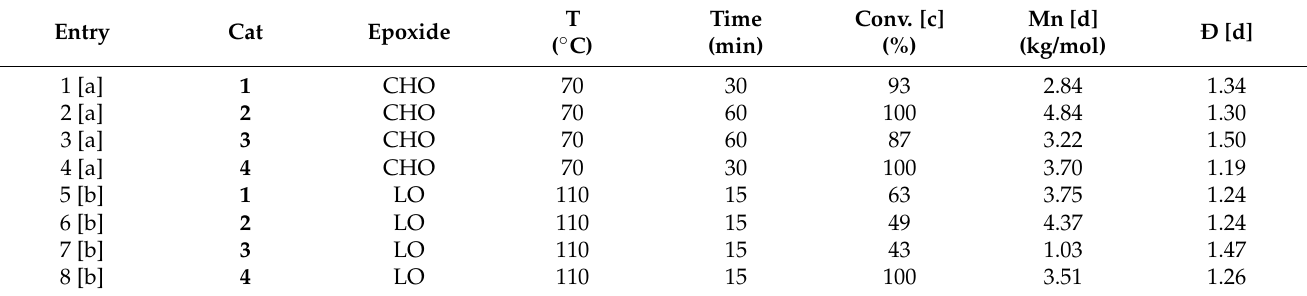
Table 2. Copolymerizations of PA with CHO or LO promoted by 1 – 4